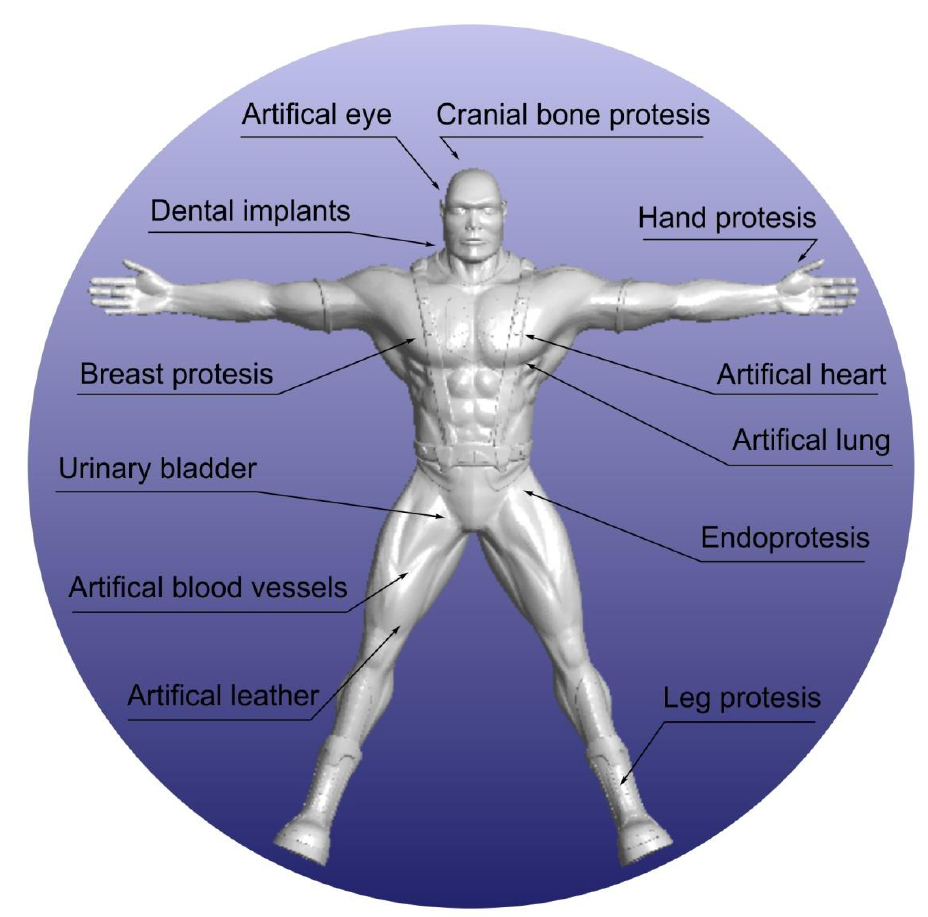
Figure 1. Examples of applications of implants and medical devices in the human body.